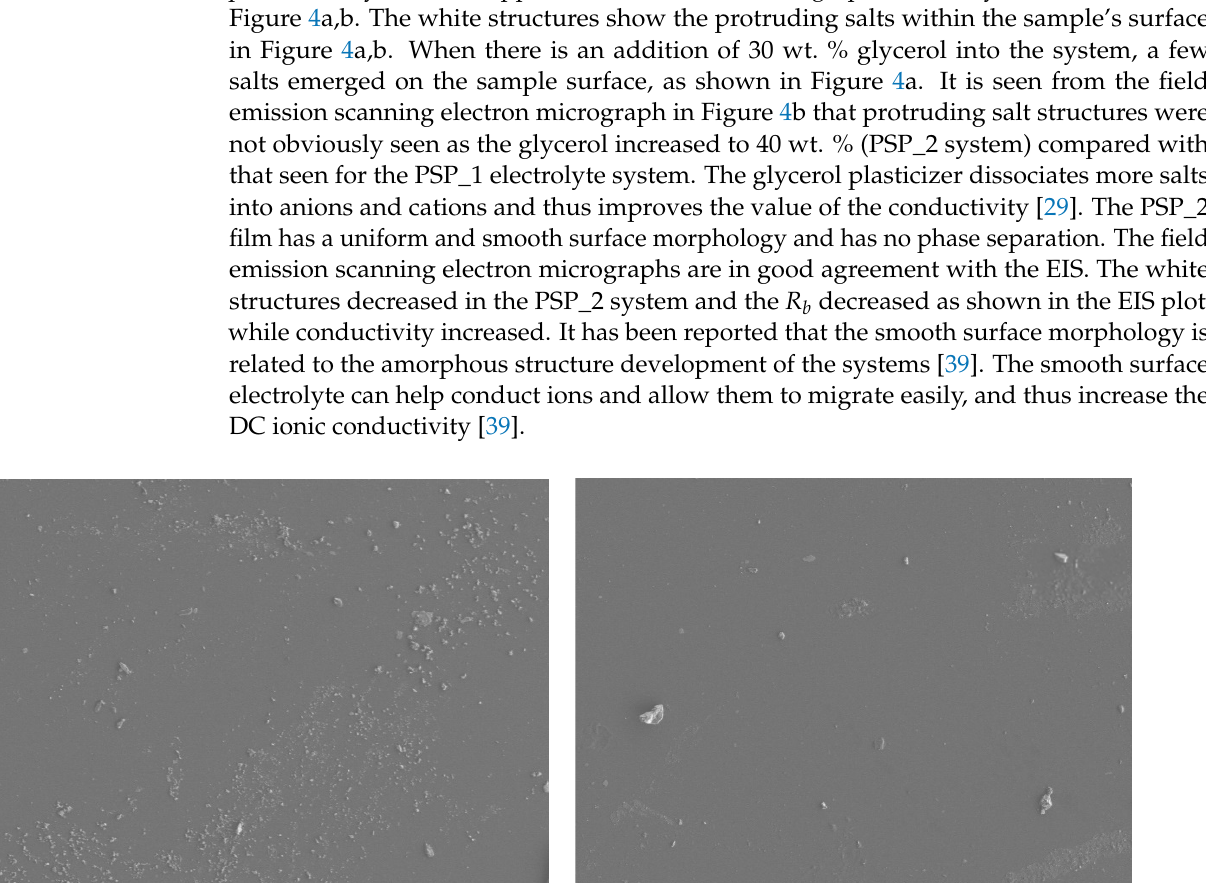
Table 4. The transport parameters of ions at RT.